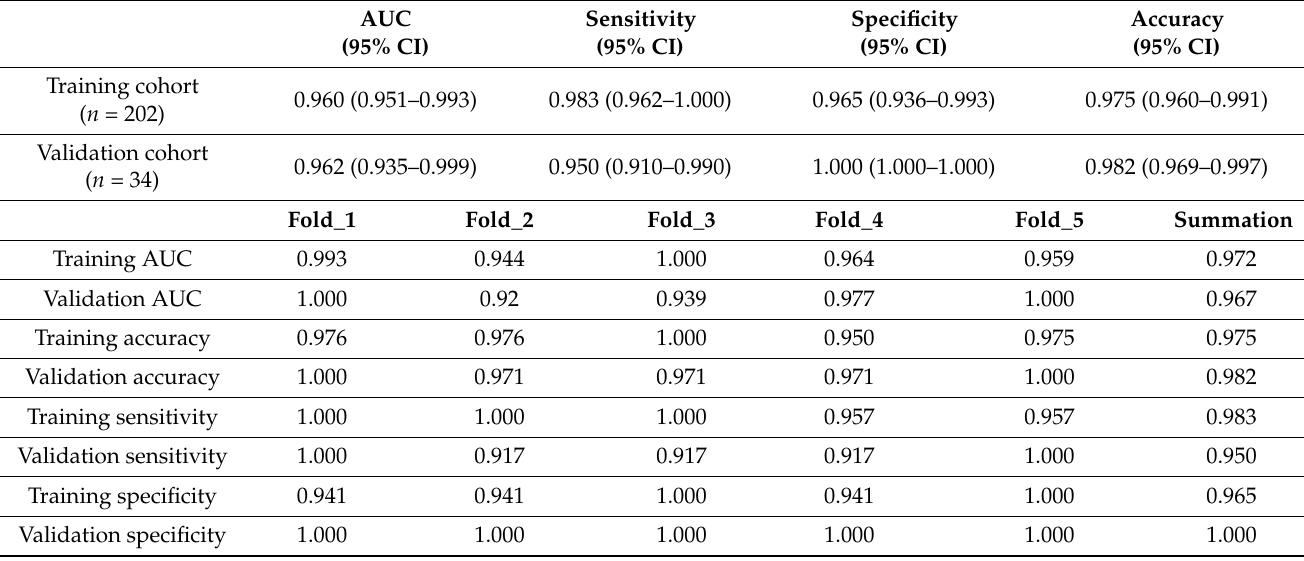
Table A1. Classification indices with metric learning and Uniform Manifold Approximation and Projection (UMAP).